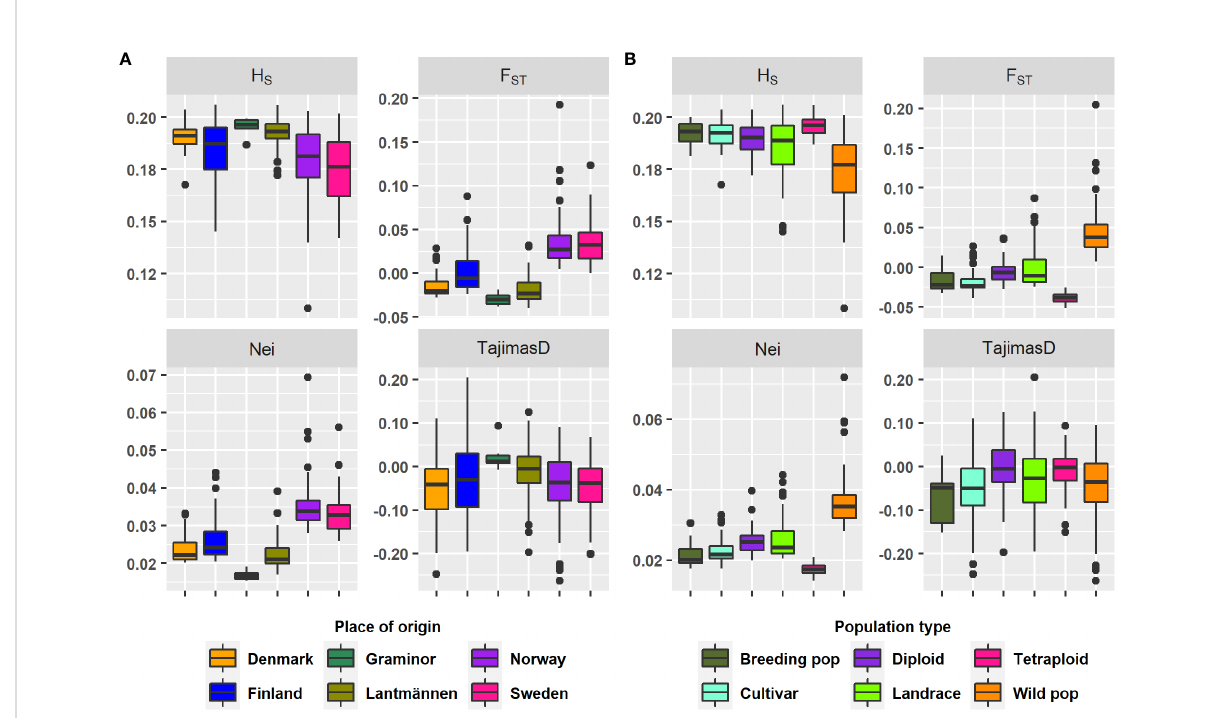
FIGURE 1 A box plot depicting the range and median for the genetic parameters on each group according to (A) Origin and (B) Type. The genetic parameters were H S , mean expected heterozygosity; Nei, Nei ’ s standard genetic distance; F ST , mean fi xation index; Tajima ’ s D, Tajima ’ s population genetic test